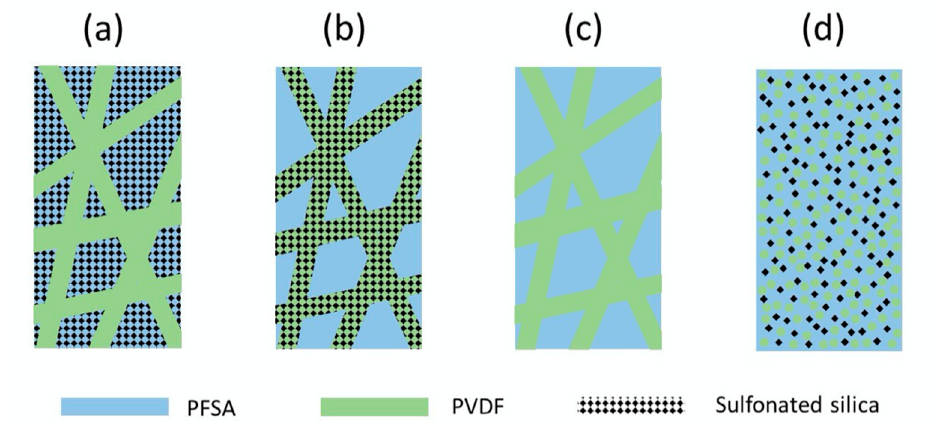
Figure 2. Schematic representations of the membranes fabricated in this study. ( a ) Membrane Type-A, ( b ) Membrane-Type-B, ( c ) Membrane Type-C, and ( d ) Membrane Type-D.